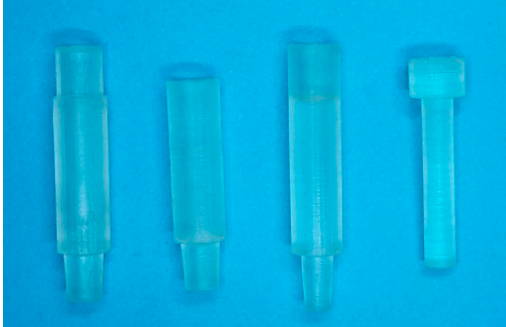
Figure 5. Picture of the 3D printed parts used in this research. Shown are from left to right: female Luer to filter holder adapter, filter holder, filter holder to male Luer adapter and the push rod for placing the filters inside the filter holders. The outer diameters of the filter holder as well as the adapters are 7.5 mm.